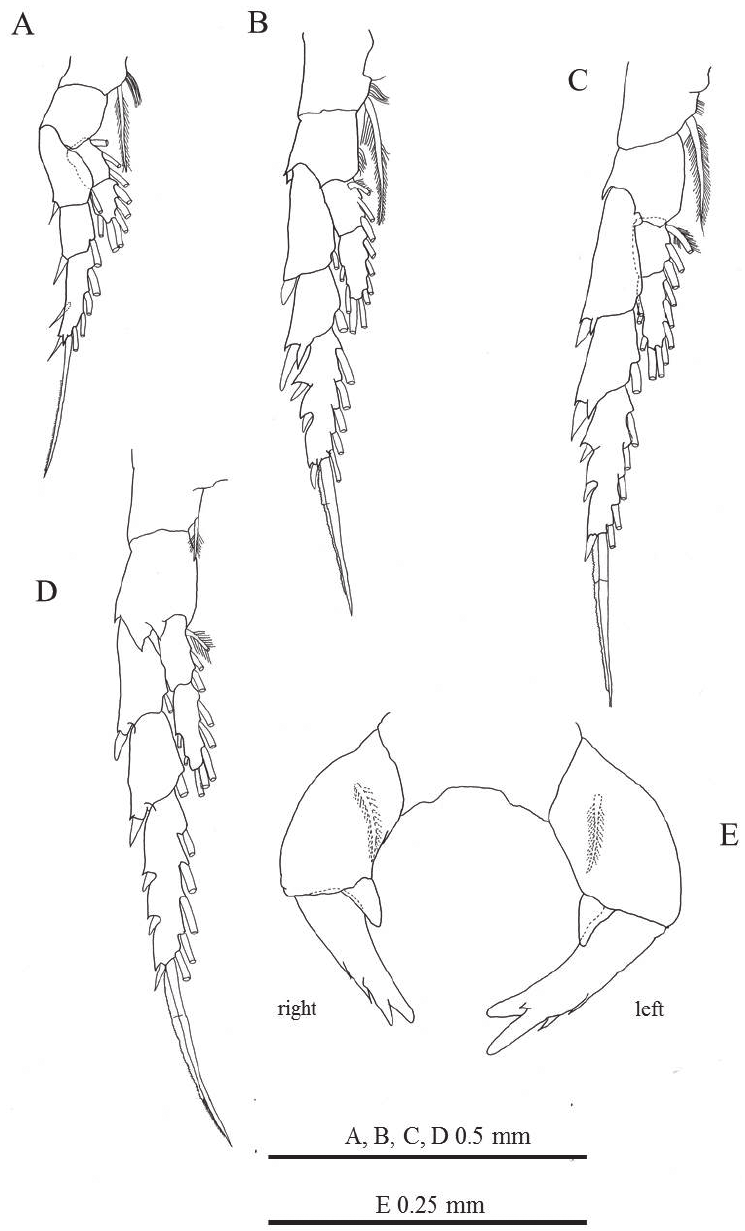
Figure 3. Labidocera churaumi sp. n., female (Paratype). A leg 1 B leg 2 C leg 3 D leg4 E leg tinguished from L. madurae and L. tasmanica by: (1) the presence of right postero- lateral and left antero-lateral processes on the female genital compound somite; (2) the exopod of the female leg 5 is very short, only as long as the basis, and has a bi-